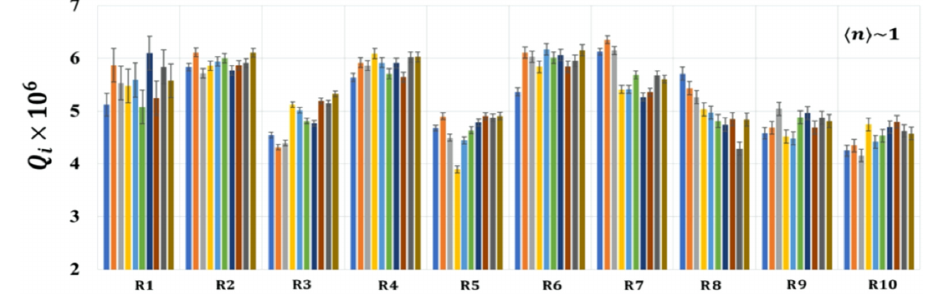
FIG. 19. Repeated measurements of Q int for all resonators (R1–R10) on the 1200-s BOE-etched chip recorded in sequence. The measurement cycle is repeated ten times for 100 total measurements, with each Q int measurement taking 480 s for a total time of 13.5 h. The blue bars are the first set of measurements, the orange the second, etc. The error bars show the fitting uncertainty. R2, R4, and R6 show consistently high performance, while others such as R3 and R8 respectively increase or decrease over time. δ TLS ≈ δ hi for this